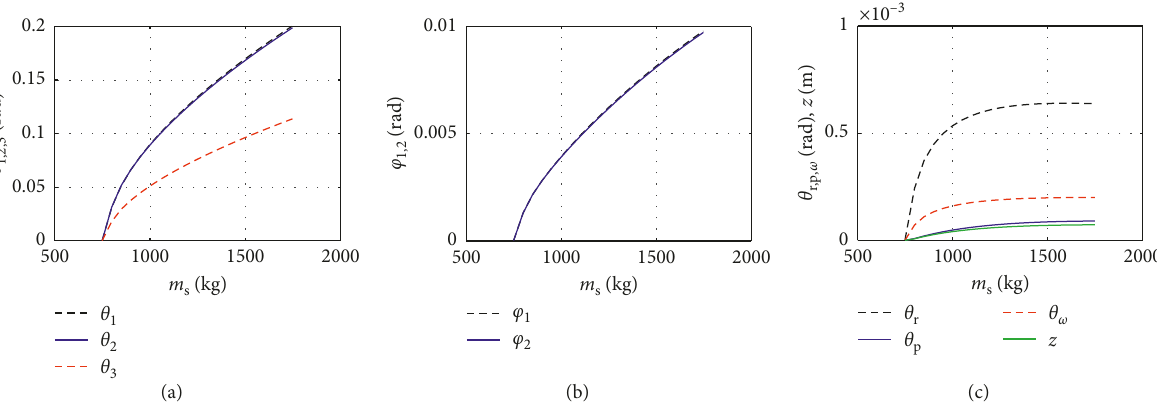
Figure 8: Influences of m s on the amplitude of each DoF. (a) The amplitudes of θ 1,2,3 . (b) The amplitudes of φ 1,2 . (c) The amplitudes of θ r,p, ω , and z .